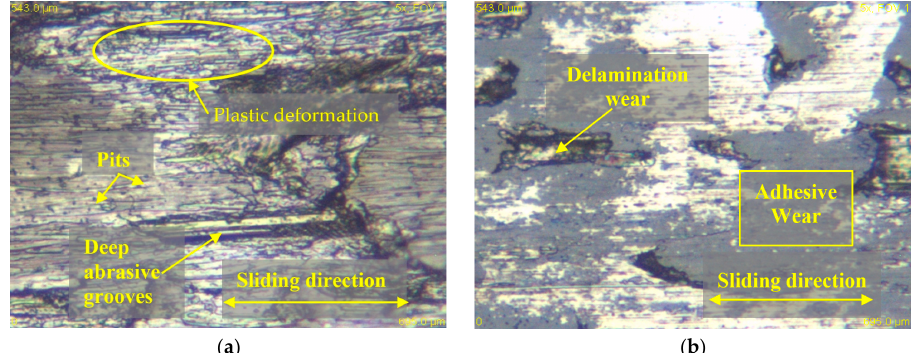
Figure 12. Wear analysis of worn surfaces 90MnCrV8: ( a ) 0.2 m/s, ( b ) 1.2 m/s.